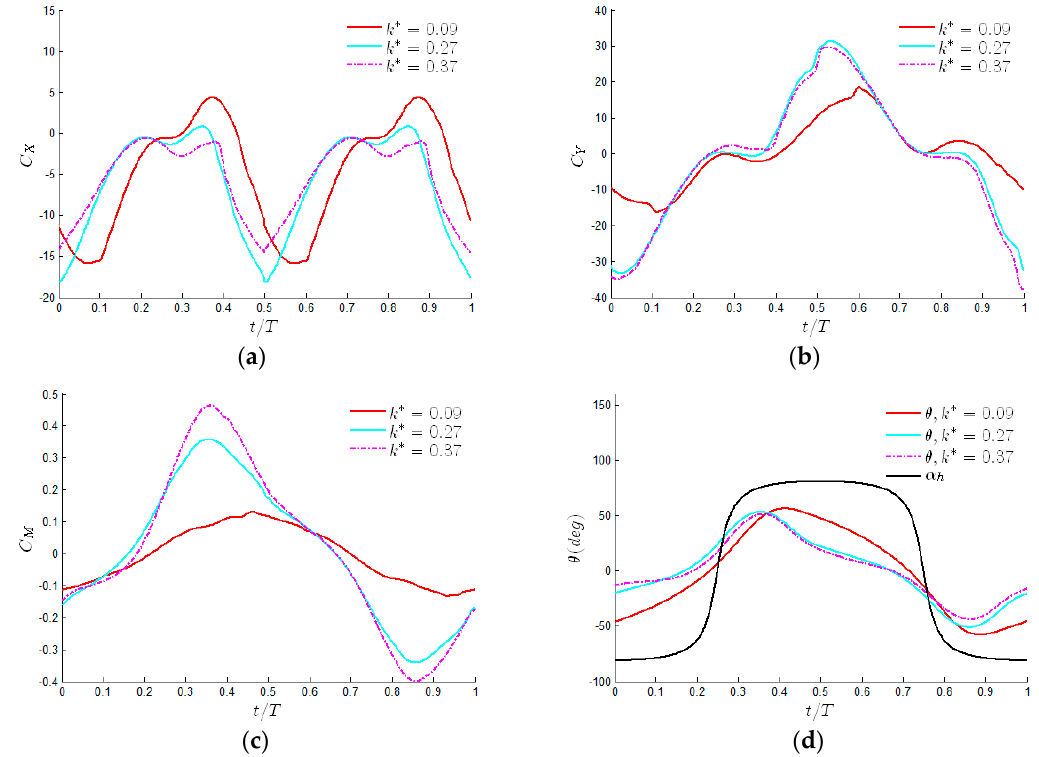
Figure 12. Evolution of (a) the thrust coefficient, (b) the lift coefficient, (c) the moment coefficient, and (d) the pitching profile for 𝑘 ∗ = 0.09, 0.27, 0.37 , 𝑦 (cid:2868) = 0.2 , 𝑓 ∗ = 0.17 .